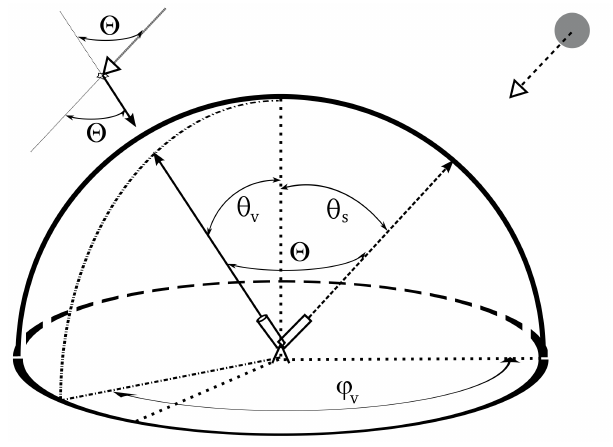
Fig. 2. Figure used to describe the scattering angle in terms of solar position and the observation angle